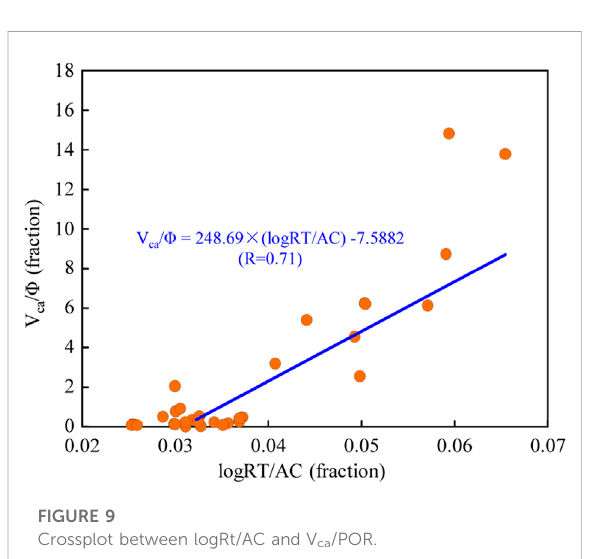
FIGURE 9 Crossplot between logRt/AC and V ca